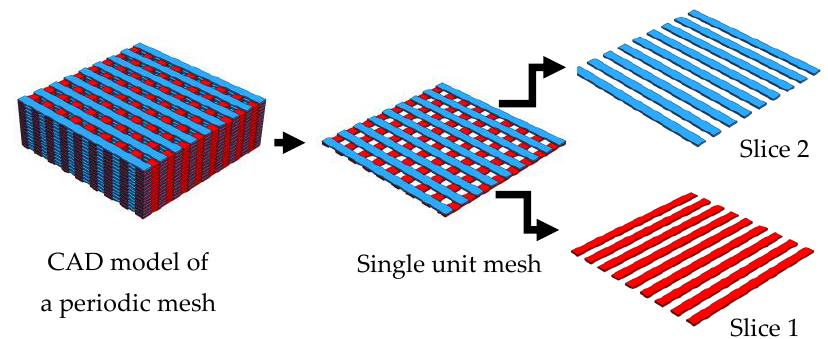
Figure 1. CAD model a periodic structure for SAM.